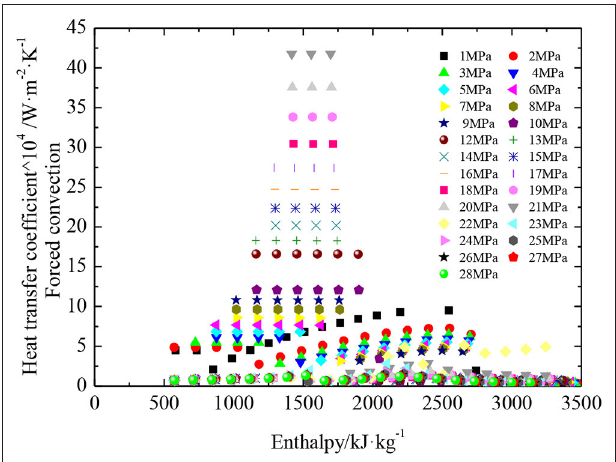
FIGURE 3 | Relationship between the heat transfer coefficient, enthalpy and pressure from a low-pressure to high-pressure